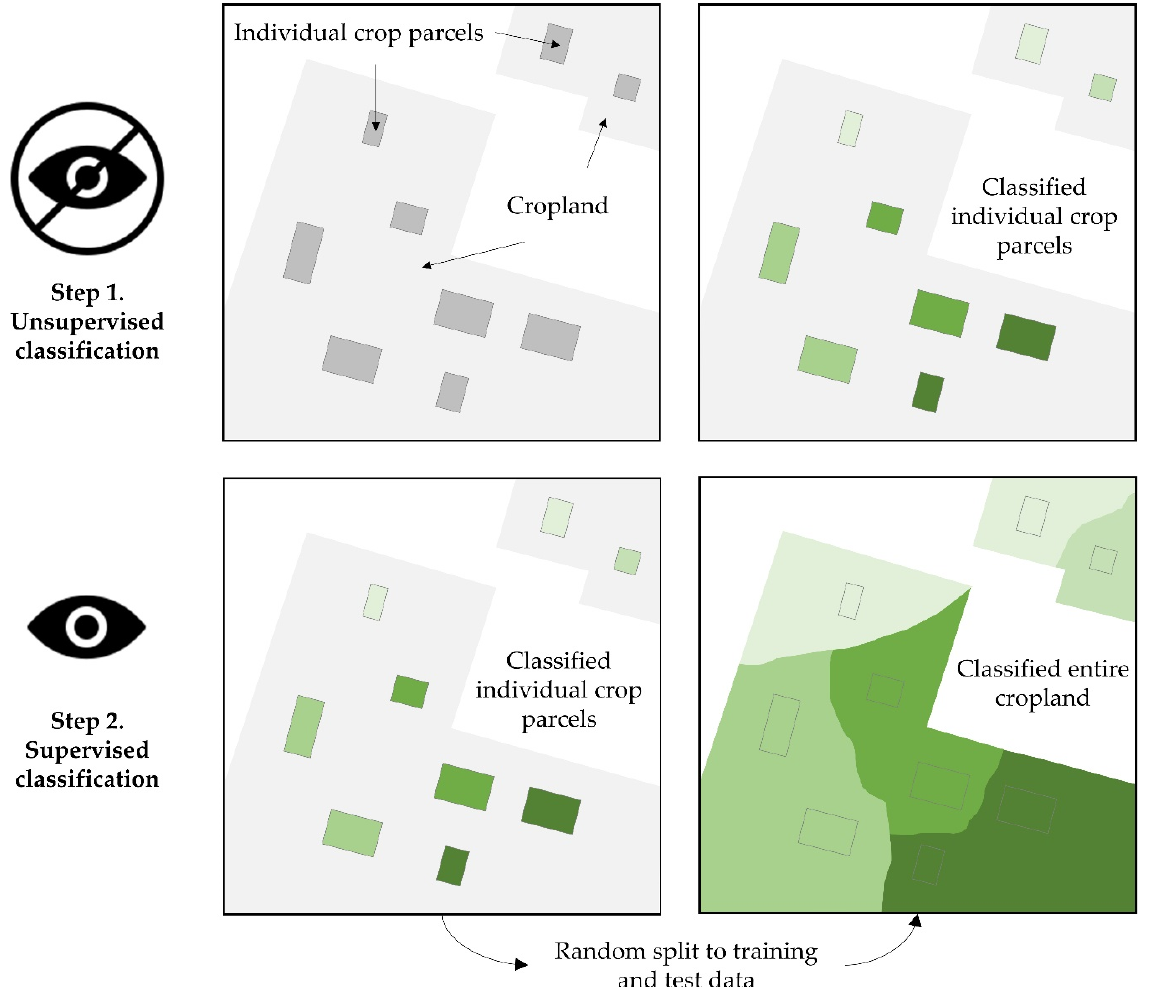
Figure 5. The cropland suitability prediction method fully based on machine learning, as proposed by [15].